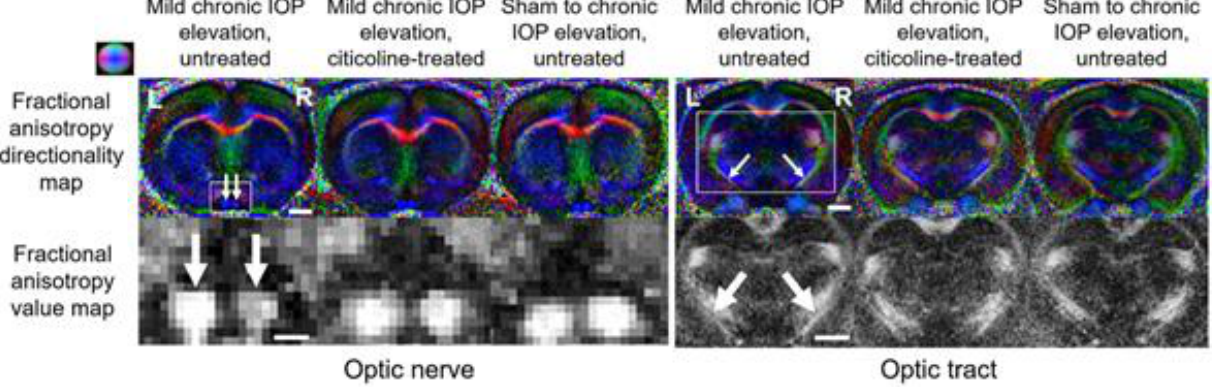
Figure 10. Representative DTI fractional anisotropy (FA) maps of the optic nerve ( left panel ) and optic tract ( right panel ) in an untreated rodent group with mild chronic intraocular pressure elevation to the right eye, a citicoline-treated group with mild chronic intraocular pressure elevation to the right eye, and an untreated sham group without intraocular pressure elevation. Top row illustrates the color-coded fractional anisotropy directionality maps, with principal diffusion directions denoted as blue (caudal-rostral), red (left-right direction), and green (dorsal-ventral). White arrows point to left and right optic nerves and optic tracts. Bottom row shows the lower FA in the right optic nerve and left optic tract of the untreated group with mild chronic intraocular pressure elevation relative to the opposite hemisphere. Such contralateral FA differences were not apparent in the other two groups. Images are adapted with permission from van der Merwe et al.